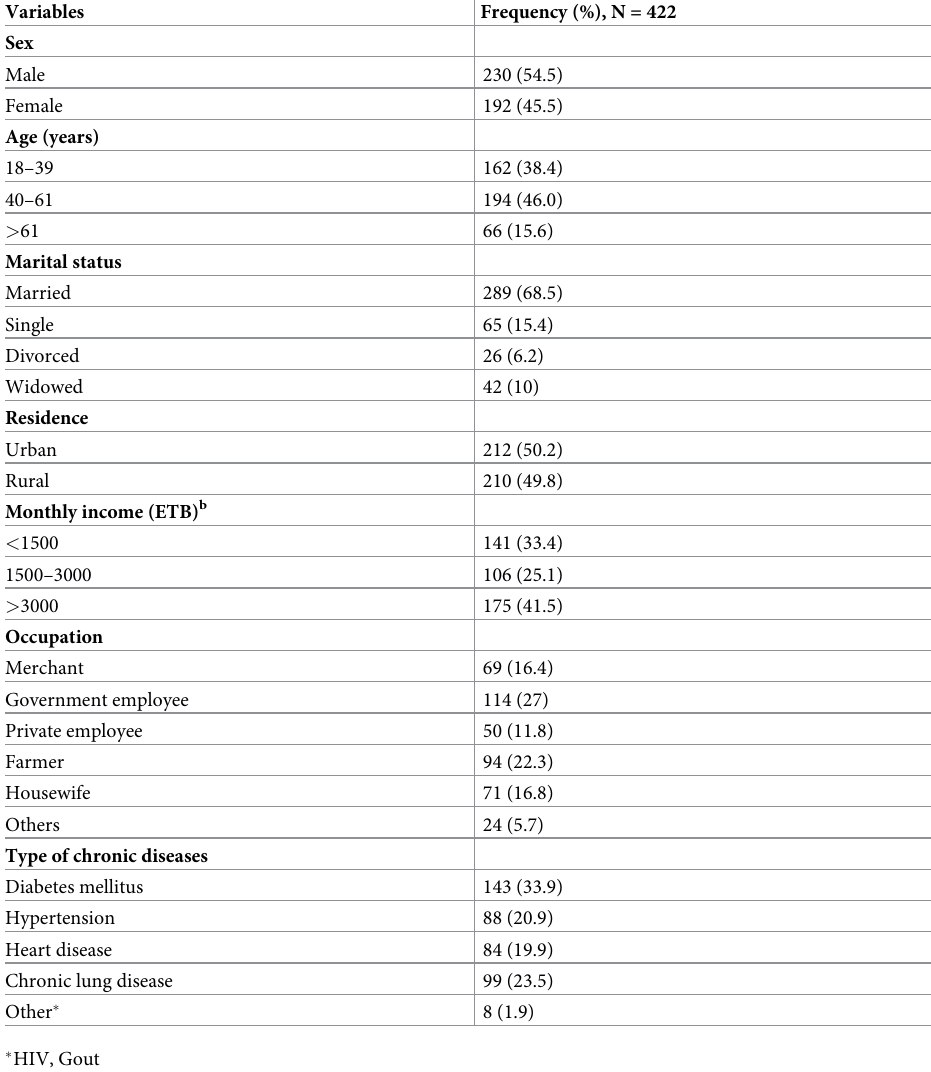
Table 1. Socio-demographic characteristics of chronic disease patients, at selected public hospitals of Sidama regional state, Ethiopia, 2020 (N = 422).